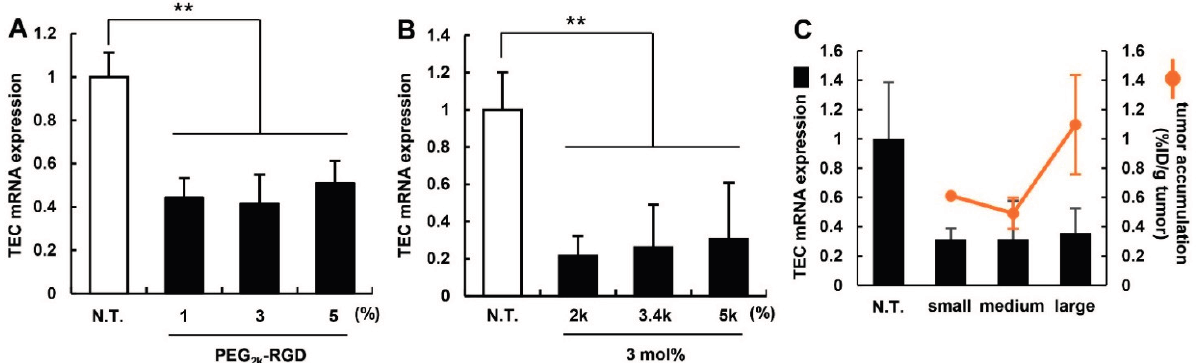
Figure 3. The in vivo silencing efficiency of the RGD-modified MEND vivo . When the density of the ligand ( A ) and the length of PEG-linker ( B ) were varied, the gene silencing in TECs in murine tumor-bearing mice was measured by qRT-PCR 24 h after the injection of 2.0 mg siRNA/kg body weight of MENDs. Data represent the mean ± S.D. ( n = 3). ( C ) When the MENDs (small: 98 d.nm, medium: 137 d.nm, large: 282 d.nm in diameter) were systemically administered into mice, the TEC mRNA level and tumor accumulation amount were evaluated by qRT-PCR and fluorescent intensity of the MENDs. The black bar and orange line indicate